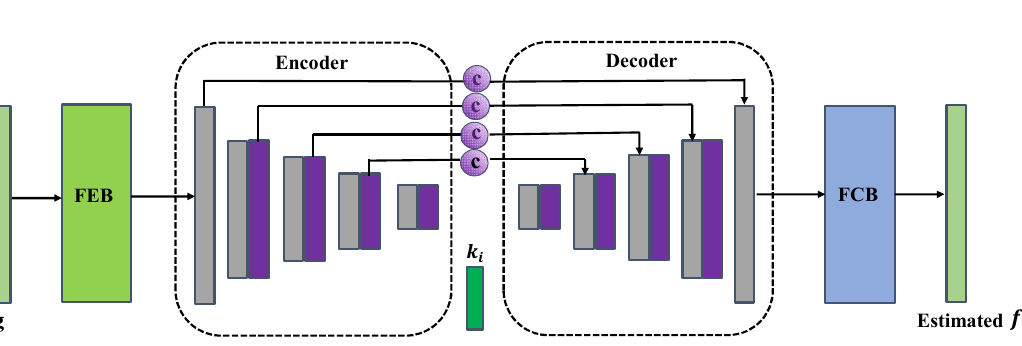
Figure 5. Structure of Network D2 (training processing).